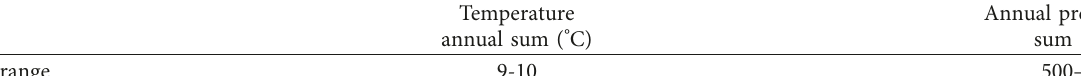
Table 1: Climate conditions for grain maize planting in the Czech Republic.